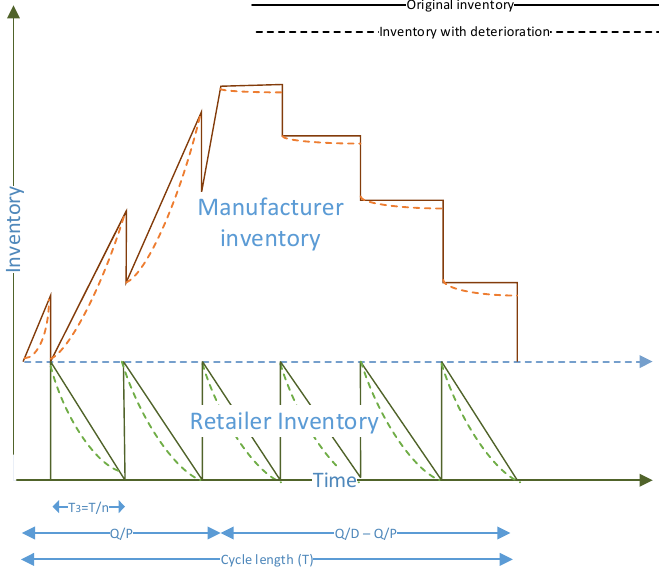
Figure 2. Inventory diagram for manufacturer and retailer.